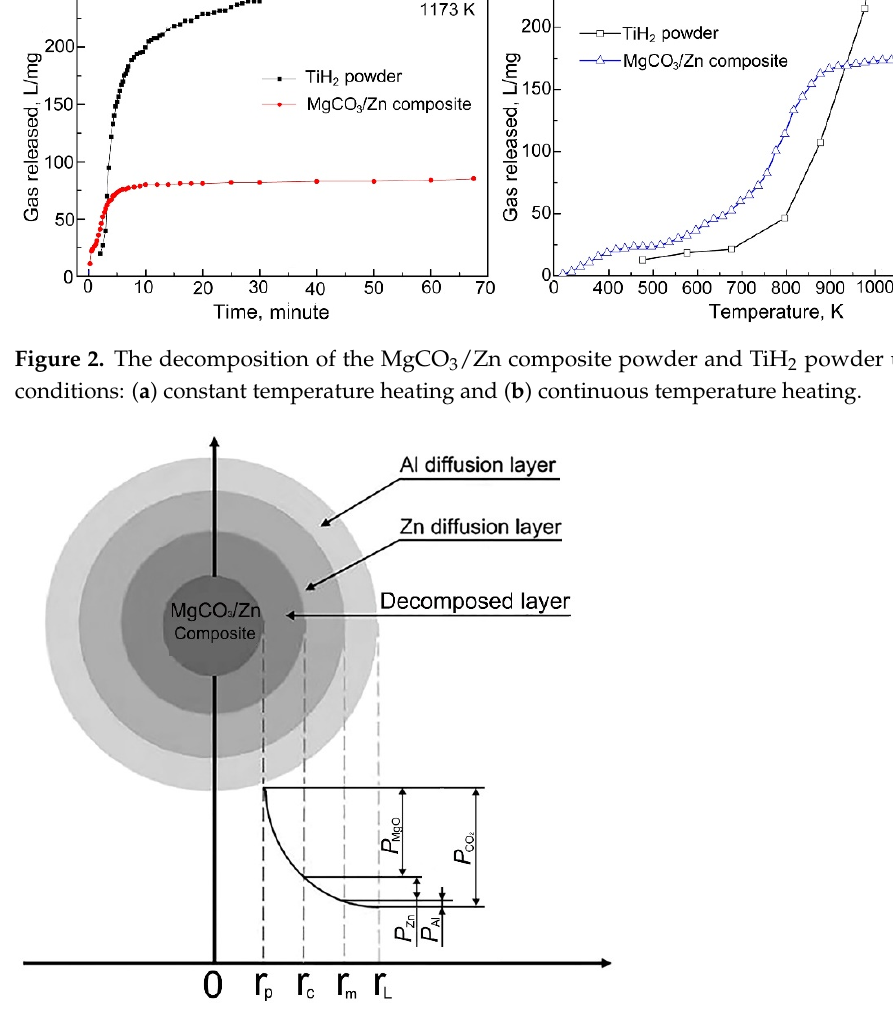
Figure 3. The decomposition model of the MgCO 3 /Zn composite powder in molten